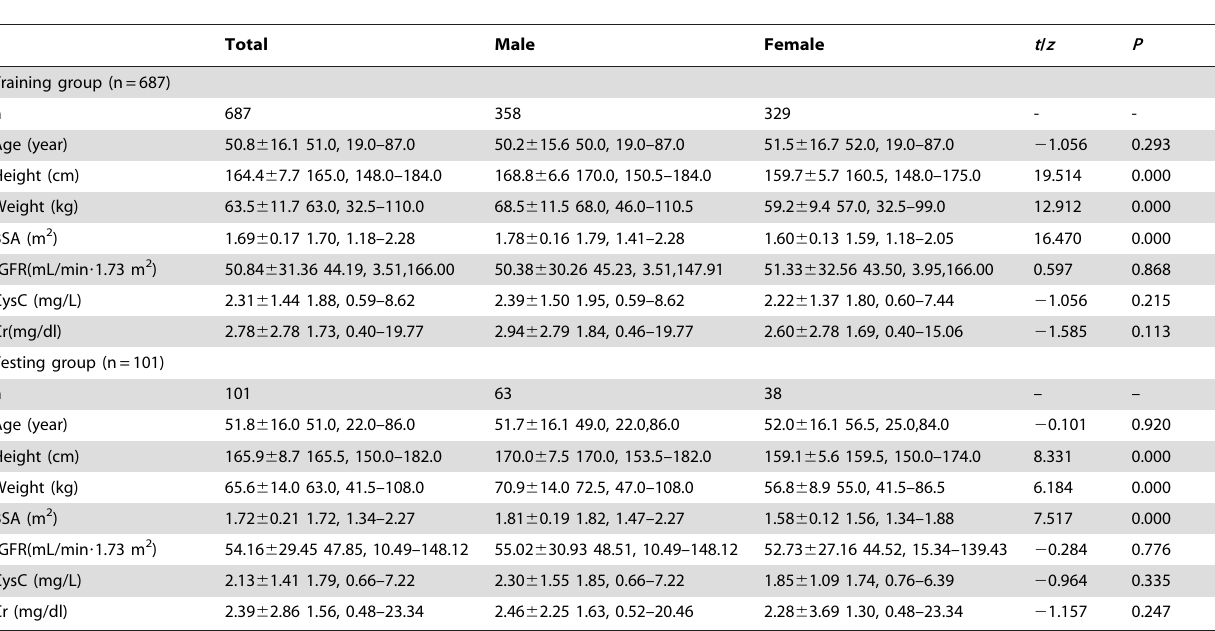
Table 1. Demographic characteristics of the 788 Chinese CKD patients (up line: mean 6 SD, down line: median, range).